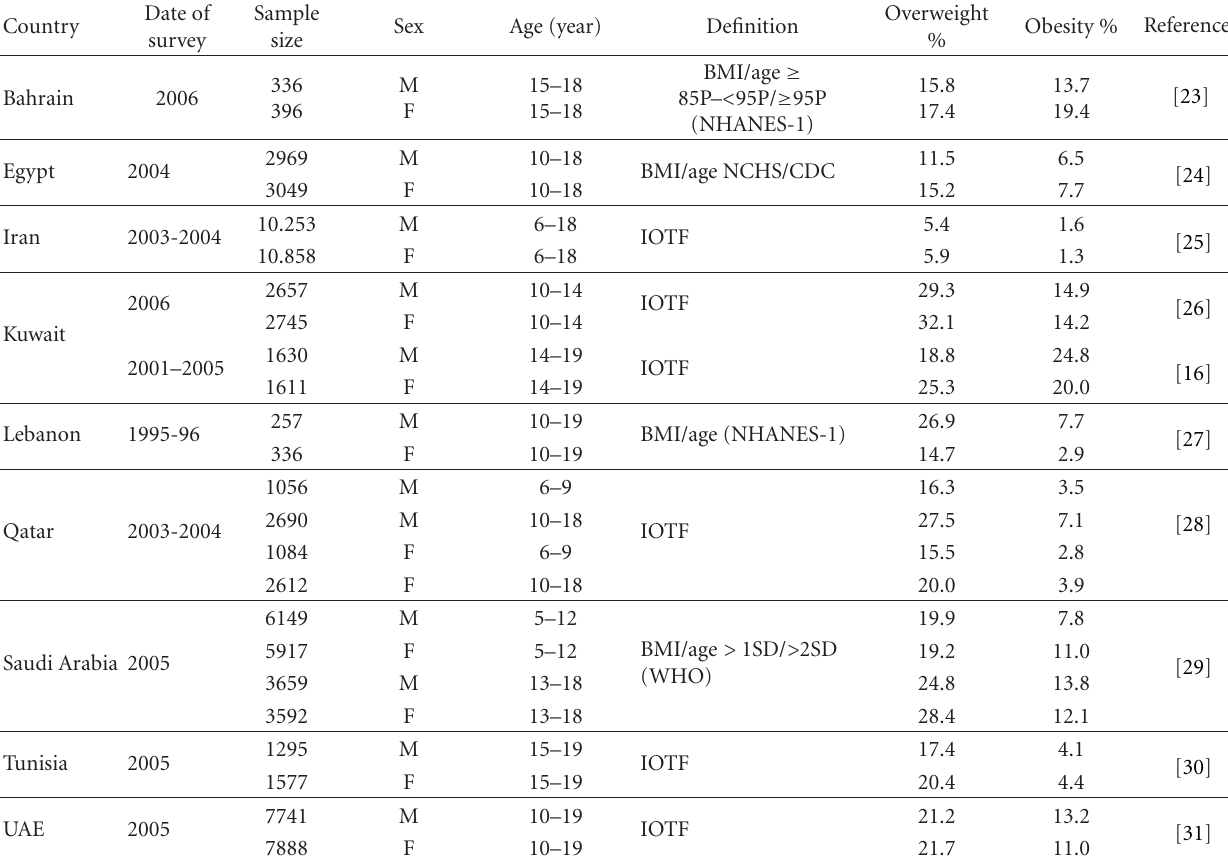
Table 2: National prevalence of overweight and obesity among school children and adolescents in selected EMR countries.